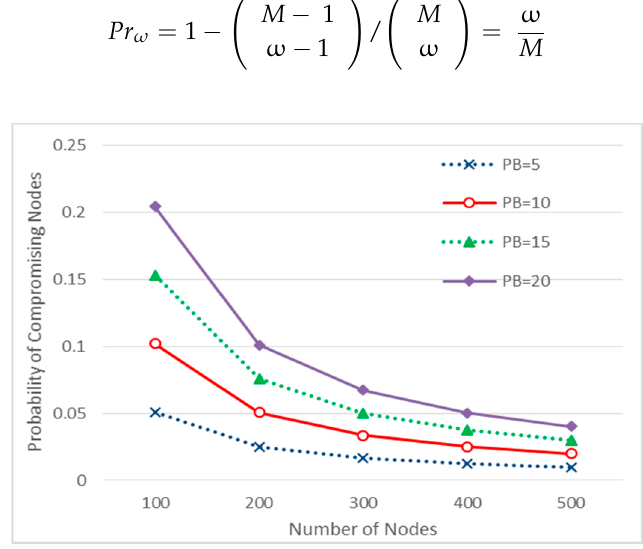
Figure 8. Probability of compromised intermediate device.